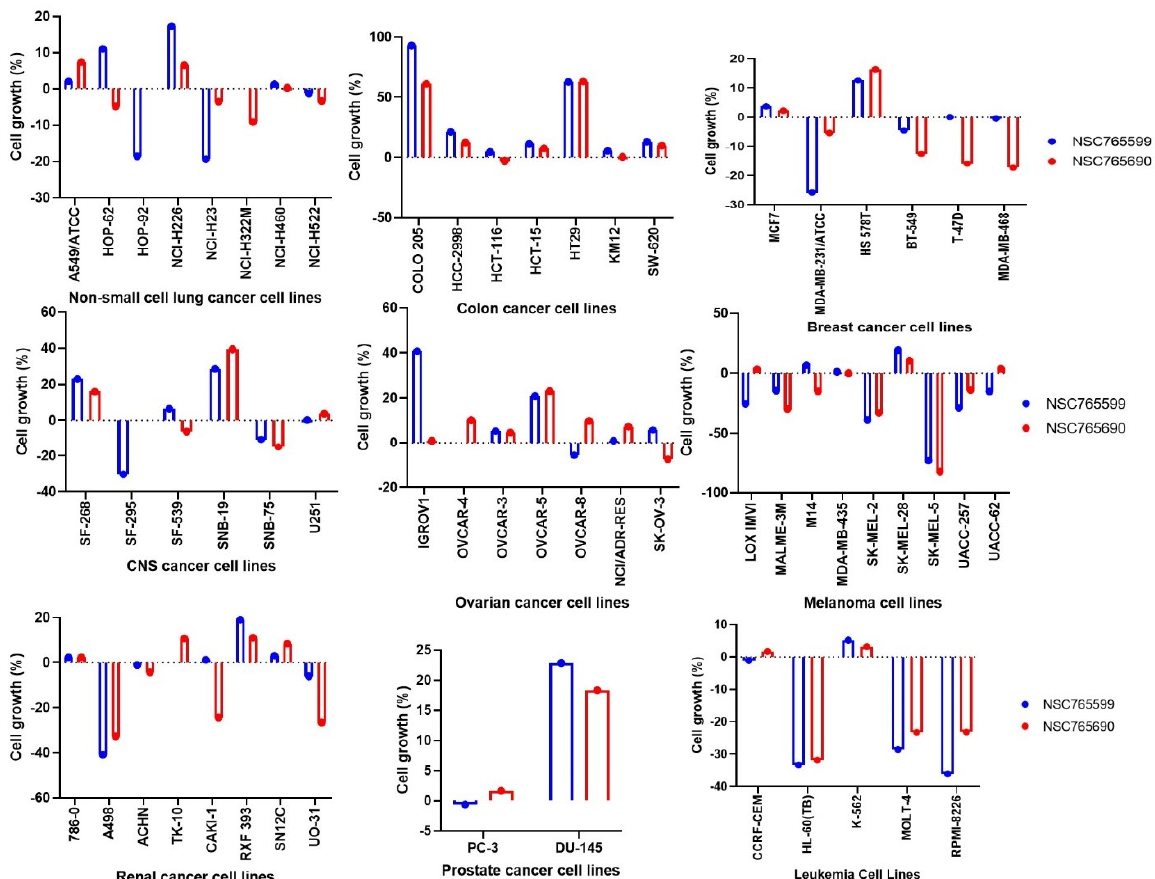
Figure 2. Anti-proliferative effect of NSC765690 and NSC765599 against panels of 60 human cancer cell lines. Each cell line was treated with a single dose of (10 μM) of each compound. The zero points denote the mean percentage of cell growth. The percentage growth inhibition of each cell line relative to the mean is represented by values under 100, whereas those values below 0 indicate cell death.